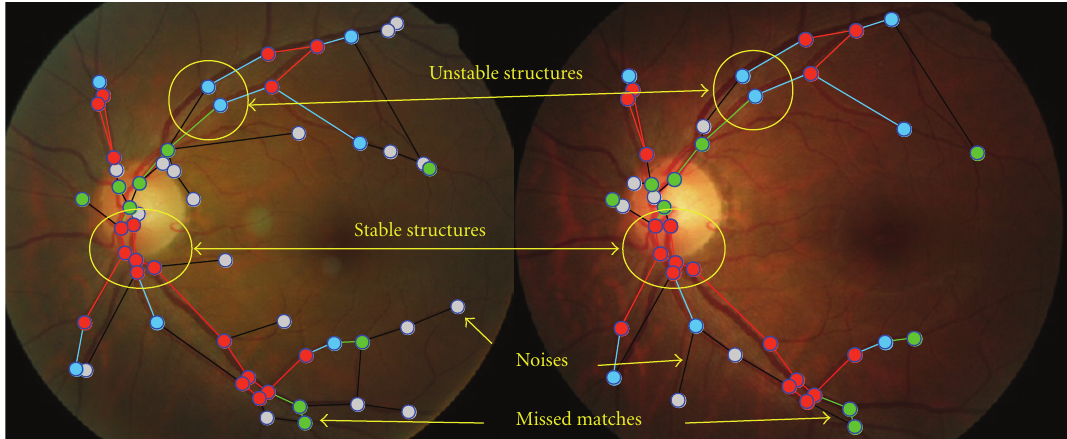
Figure 5: Illustration of the stable and unstable structures in graph matching results, where red color represents stable structures, blue color denotes unstable structures, green color represents missed structures, gray nodes, and black edges are